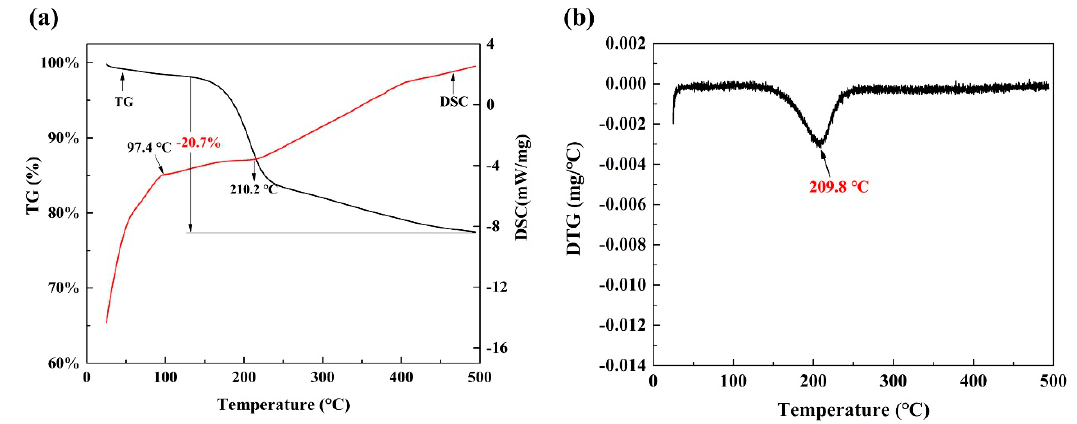
Figure 4. ( a ) Thermogravimetric analysis and differential scanning calorimetry (TG/DSC) curves and ( b ) DTG curve of spent catalysts.